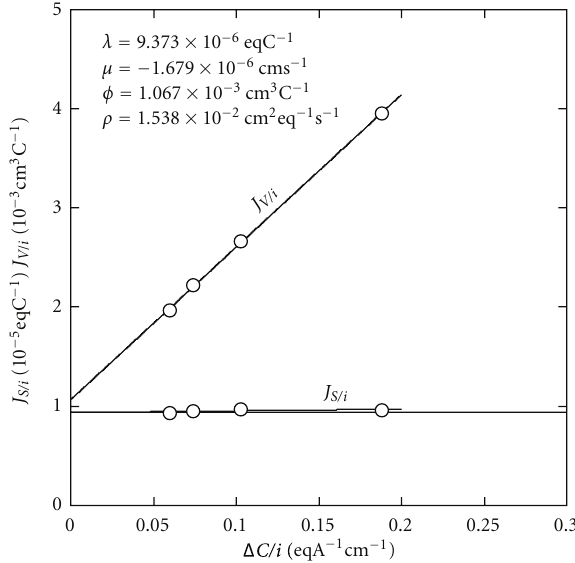
Figure 4: J S /i versus Δ C/i plot and J V /i versus Δ C/i plot. Neosepta CIM/ACS3 35 ◦